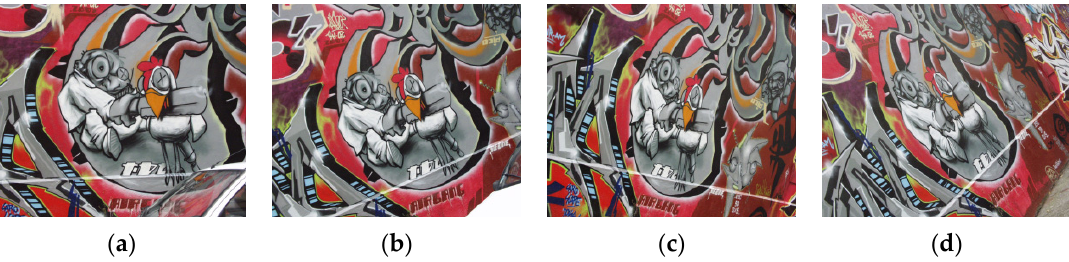
Figure 4. The multi-angle images about a same scene applied in the rough matching test: ( a ) the 0° image; ( b ) the 10° image; ( c ) the 20° image; ( d ) the 50° image.